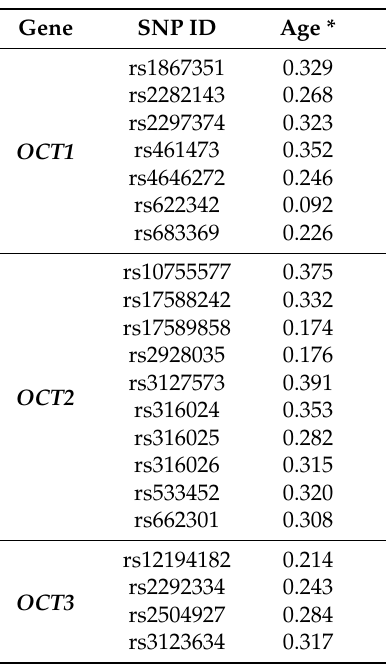
Table 7. Associations of SNPs with glycemic control in multinomial logistic regression after adjustment for age, BMI and age at diabetes